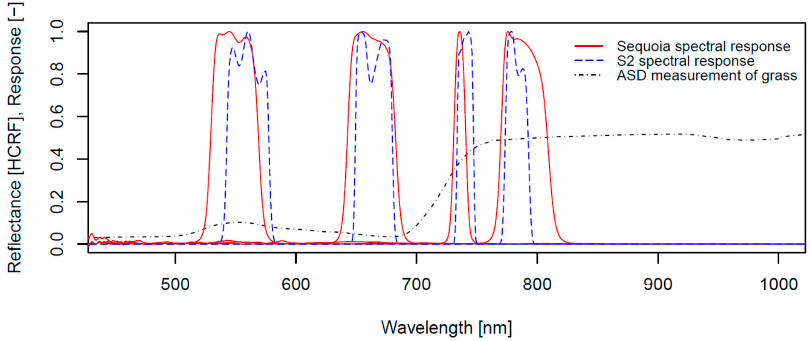
Figure 5. Relative spectral responses of a Parrot Sequoia camera (Green, Red, Red Edge and NIR), as well as the most closely corresponding Sentinel–2A bands (bands 3, 4, 6 and 7) (excerpted from [18]).